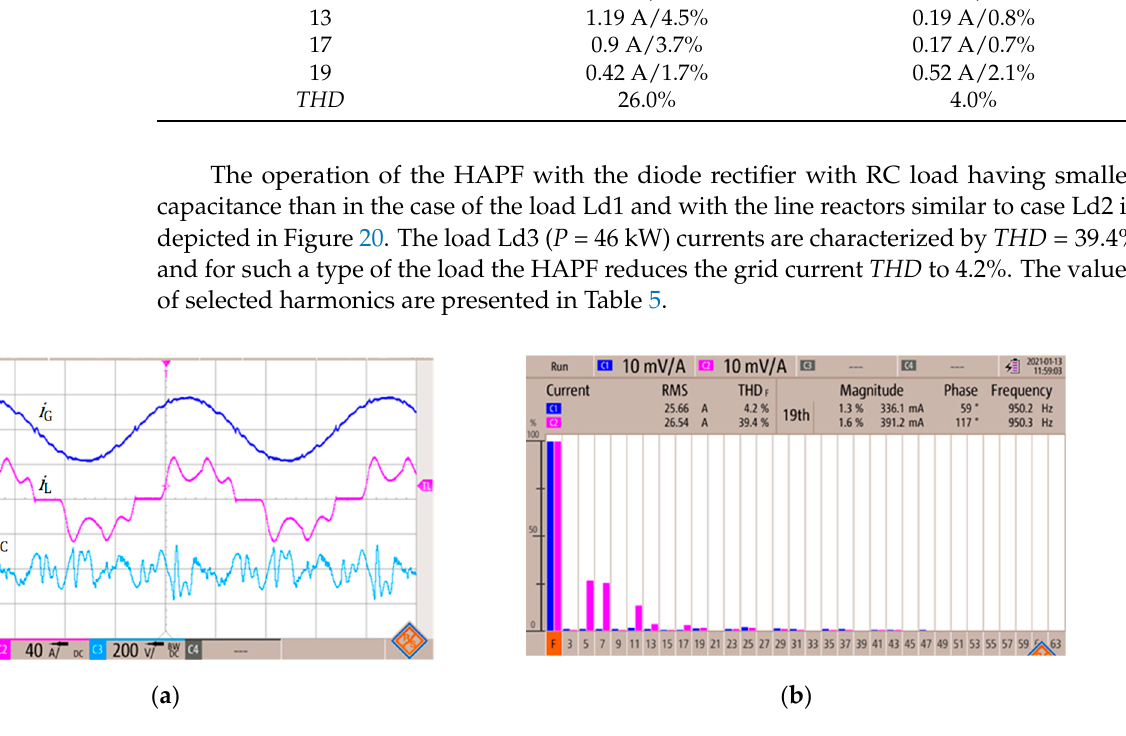
( b ) Figure 21. Example waveforms for the HAPF dynamic states ( a ) start the load Ld1 ( b ) power change of load Ld1.